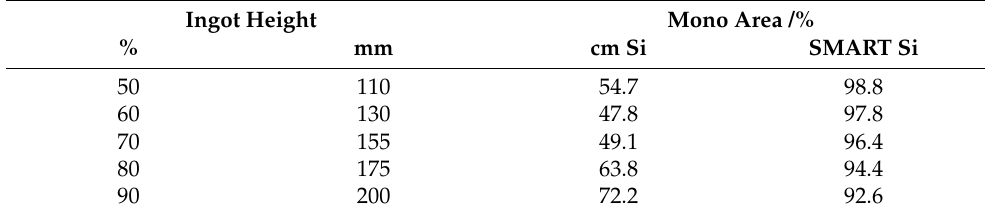
Table 1. Monocrystalline area share at different ingot heights for the cm Si and SMART Si materials. Ingot